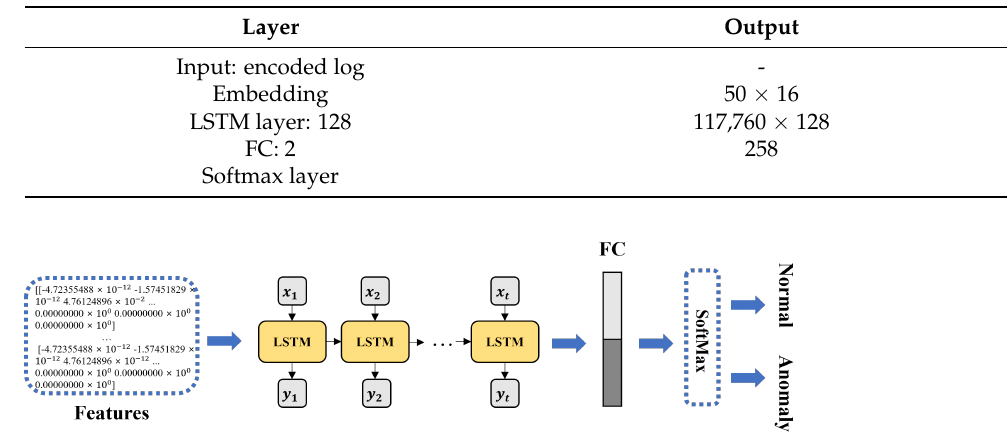
Table 2. Specific parameters of the LSTM model used in our study.